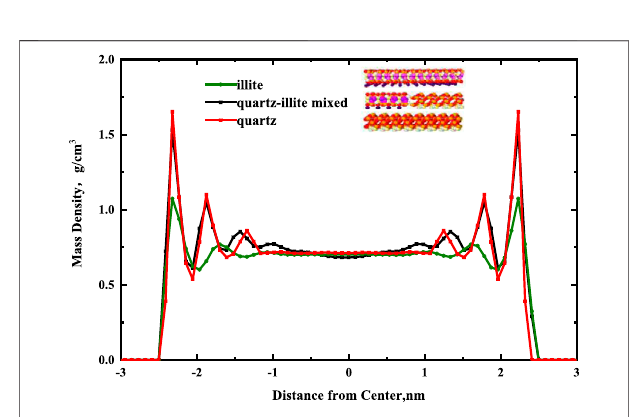
FIGURE 5 | Effects of single-component pore and multi-component mixtures pore on the mass density pro fi les for alkanes in a 5 nm pore.